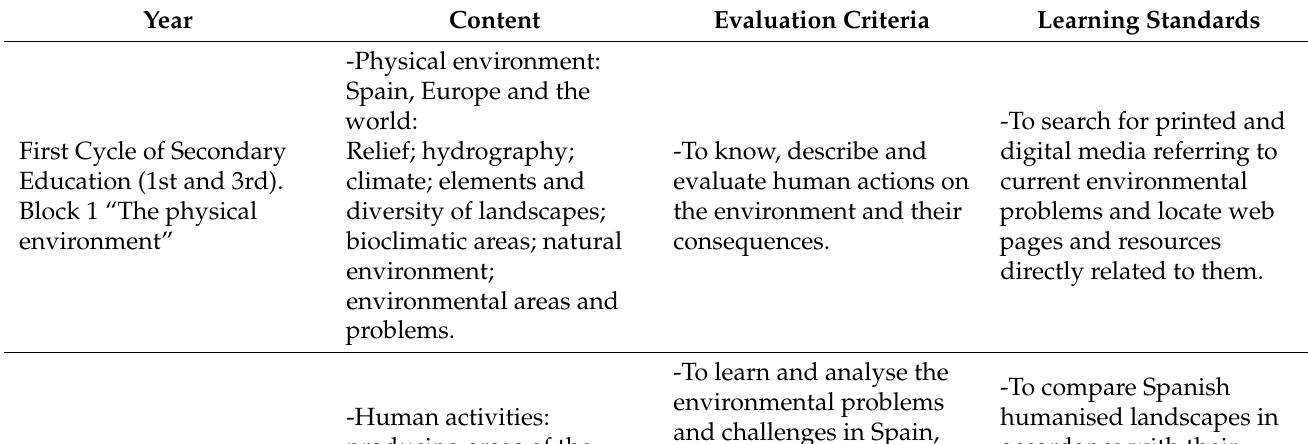
Table 1. Contents on atmospheric risks and climate change included in the Secondary Education and Baccalaureate curricula (subject of Geography,